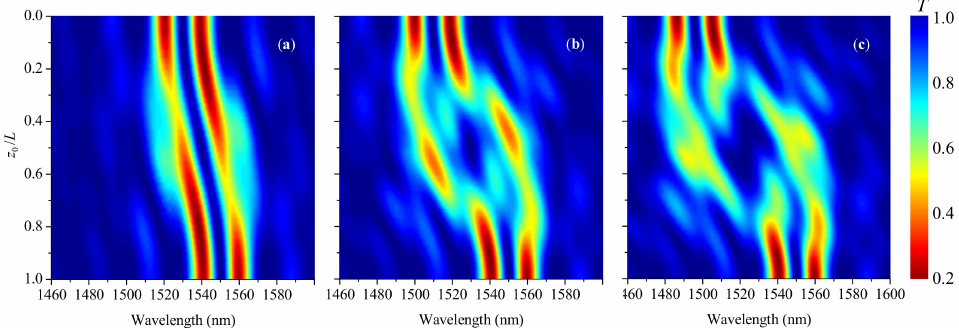
Figure 8. Evolution of transmission spectra with transition point z 0 moving through the π -shift LPFG for different strains: ( a ) s 0 = 9, ( b ) 18, and ( c ) 24 mstrain ( η =